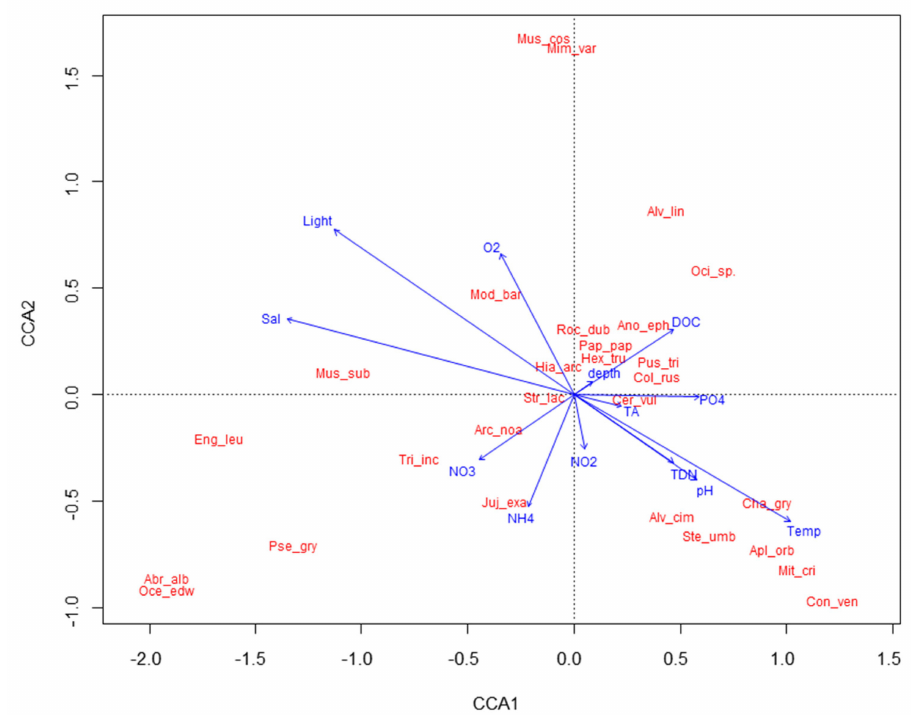
Figure 4. CCA biplot showing relationships among molluscan taxa and environmental